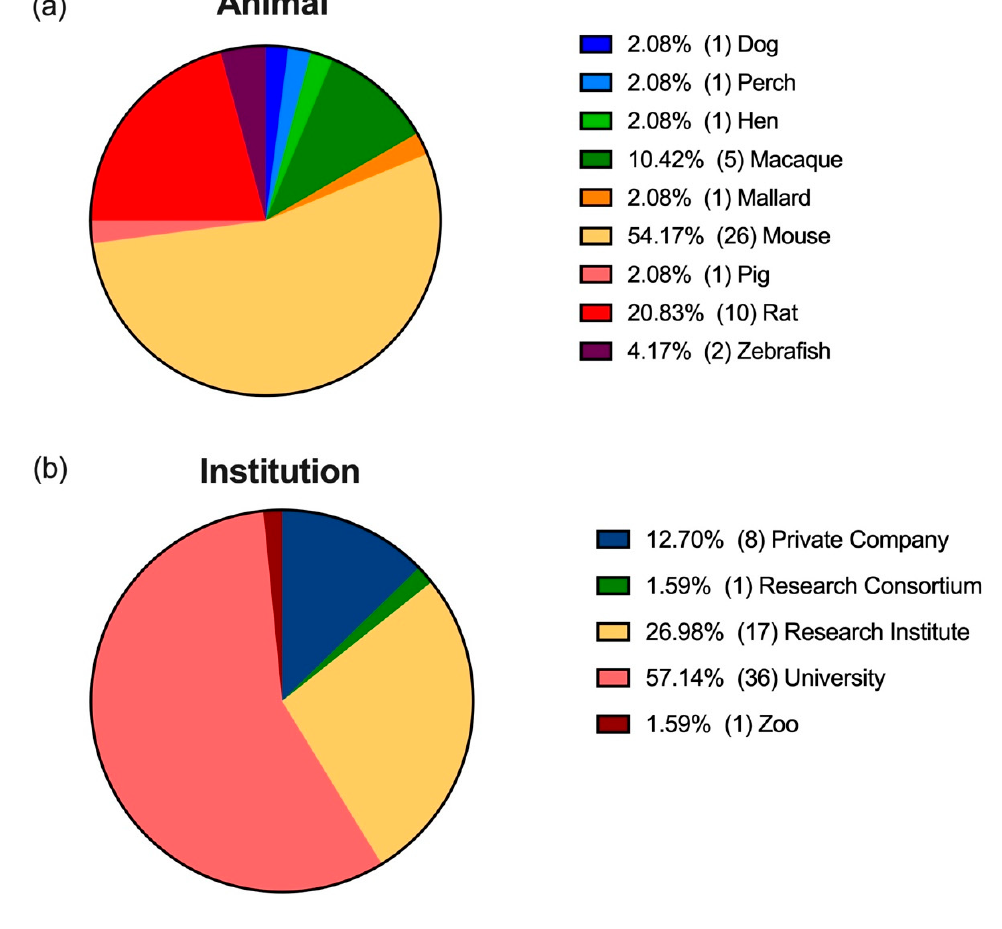
Figure 2. ( a ) Animal species for which the refinement protocols were described; ( b ) country; and ( c ) institution in which the research groups were working. Data are presented in percentages (total number).